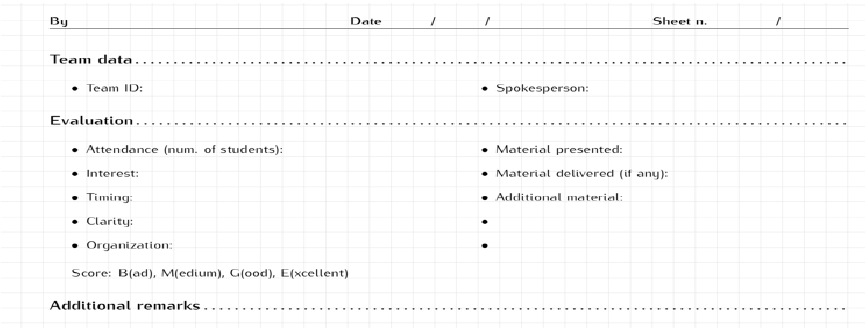
Fig. 2. The form that the tutor needs to fill after each team